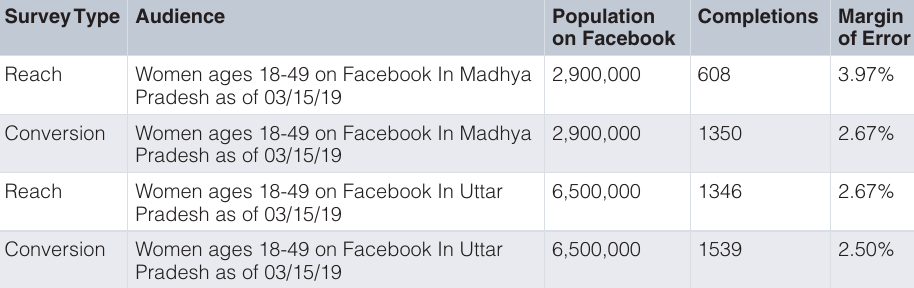
Table 1. Margin of Error calculation: = (SQRT((0.25/Survey Completions))*1.96)*(SQRT((Population on Facebook-Survey Completions)/(Population on